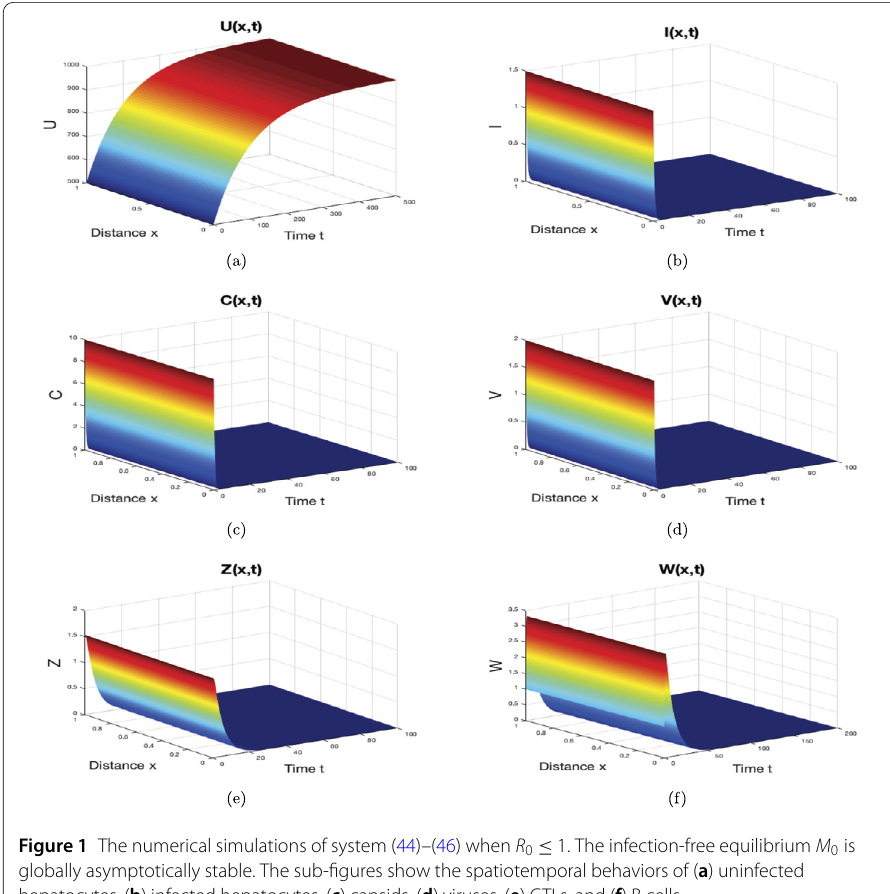
C ( x ,0) = 10 capsids mm –3